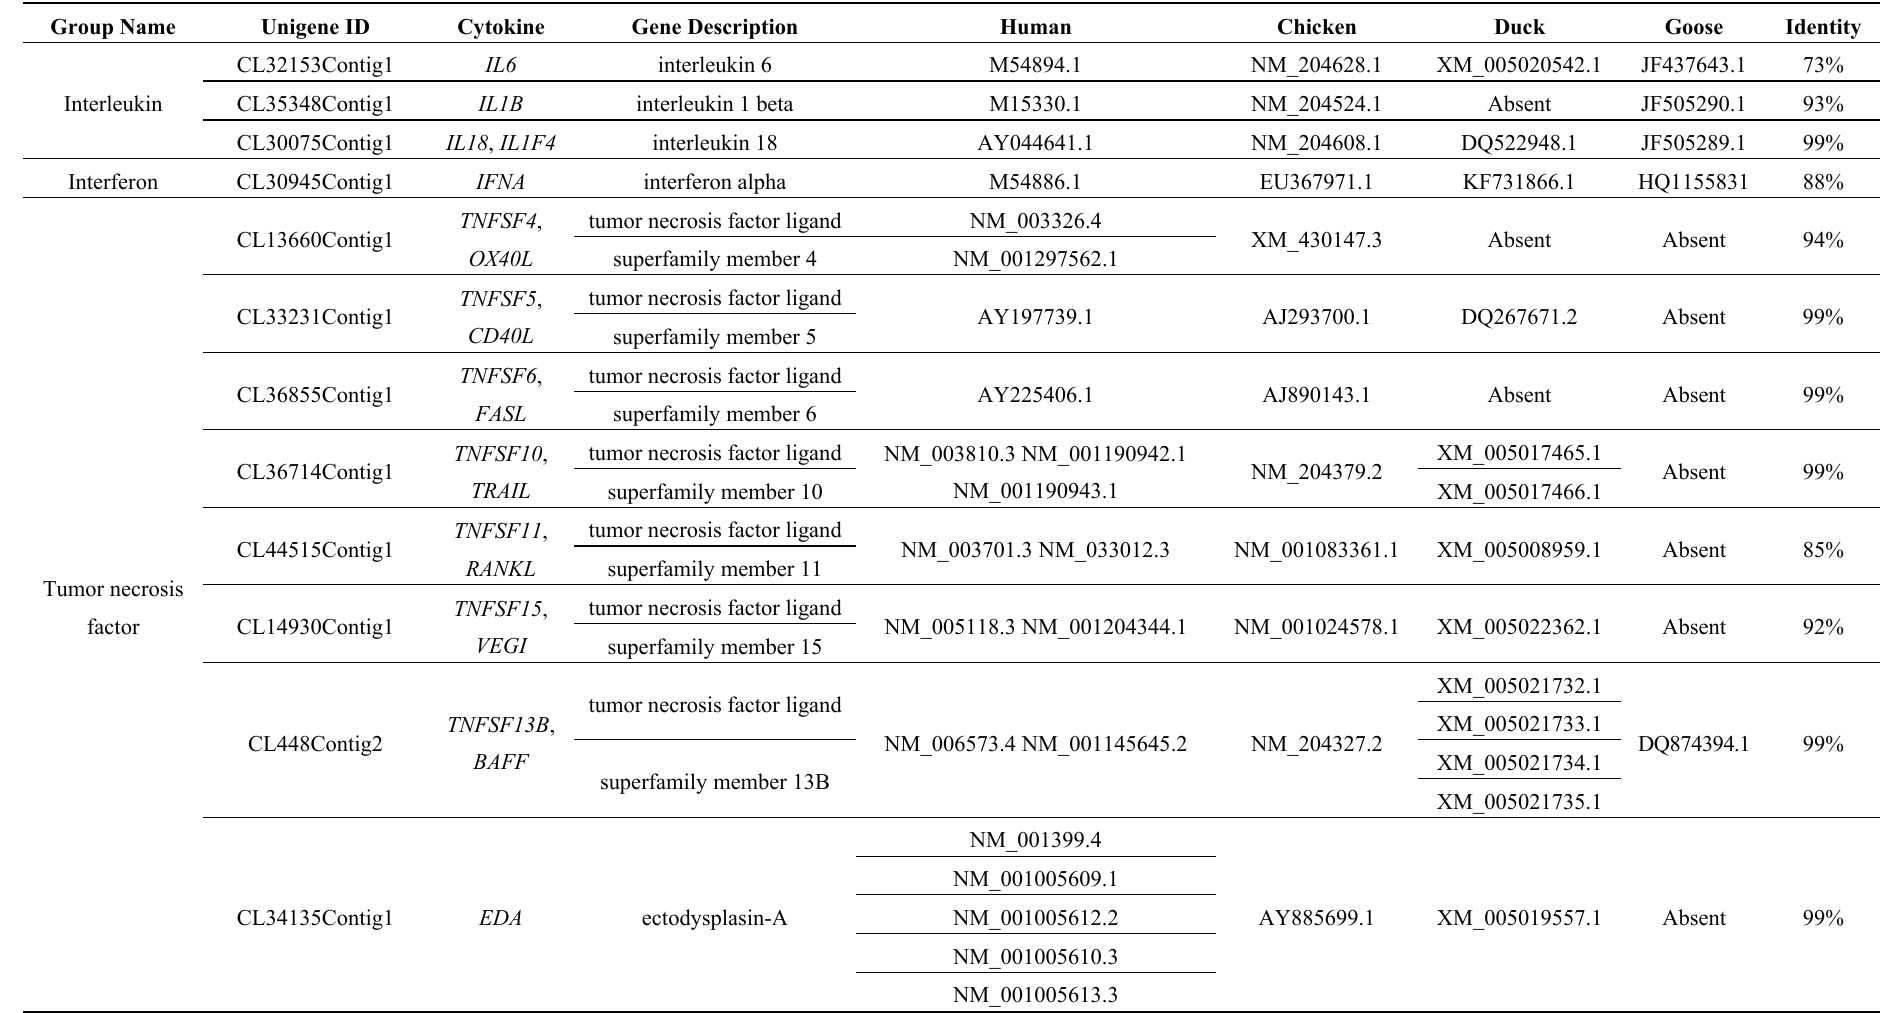
Table 3. A list of unigenes belonging to the cytokine